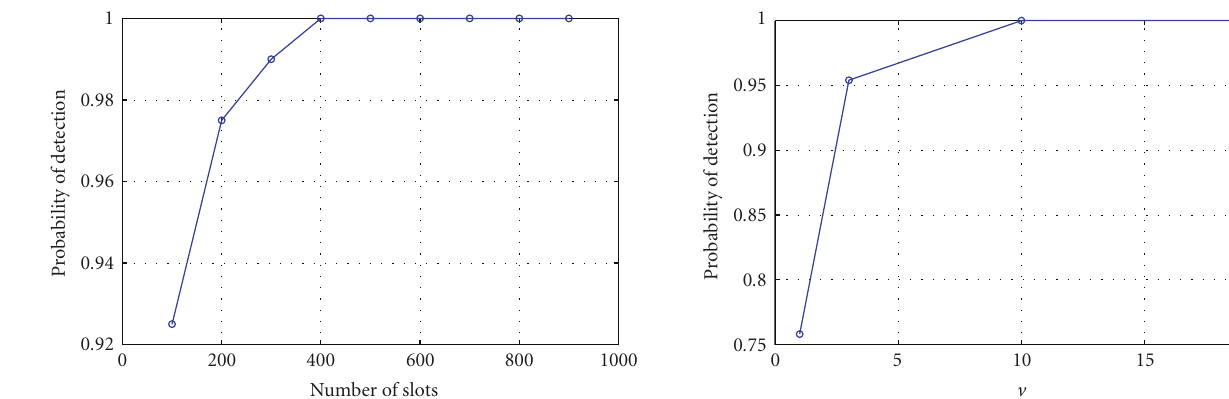
Figure 9: Probability of detection versus number of slots (N SLOT ) for K 0 = 10, v = 20m/s, and SNR = 10dB.